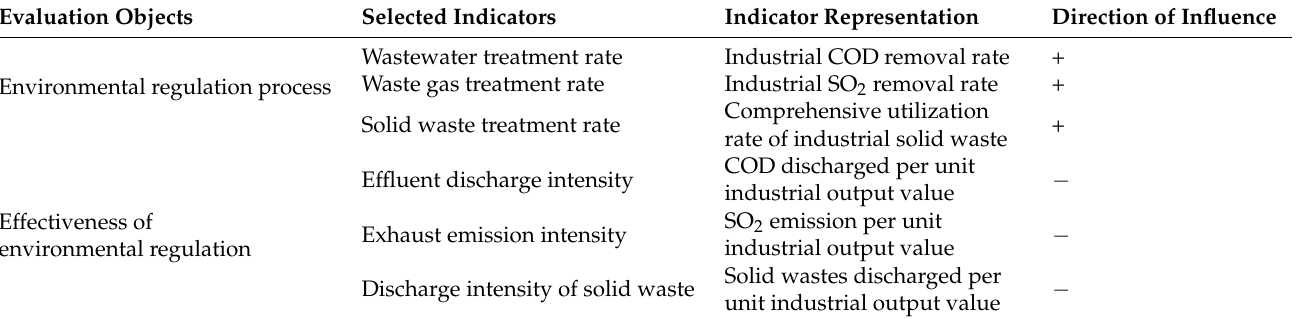
Table 2. Themeasurementsystemofenvironmentalregulations(+: positiveinfluence, − : negativeinfluence). Evaluation Objects Selected Indicators Indicator Representation Direction of Influence Environmental regulation